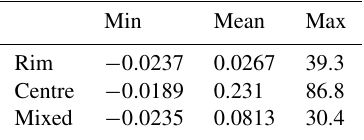
Table 4. Modelled hourly methane flux for the summer periods 2003 to 2005 for the rim, centre and a mixed approach of 65% rim plus 35% centre in mg Cm − 2 h − 1 , rounded to three non-zero digits. Summer means less than 5cm of snow are on the